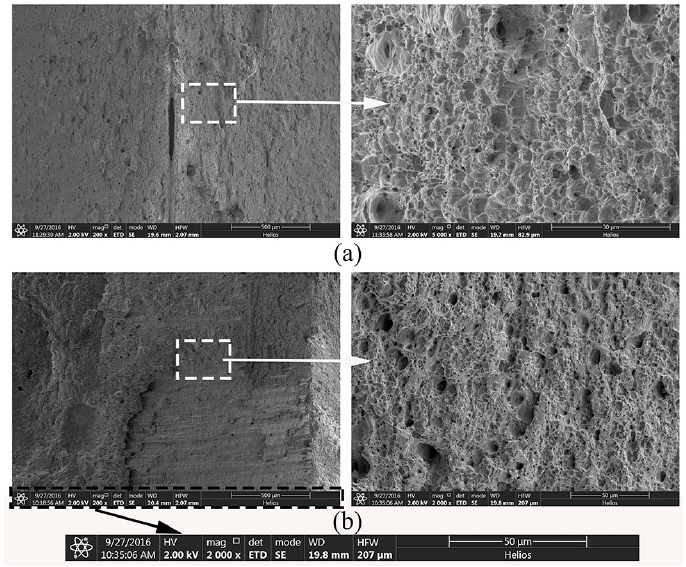
Figure 11. The failure surfaces of ( a ) the EH36 base material and ( b ) the welding joint.